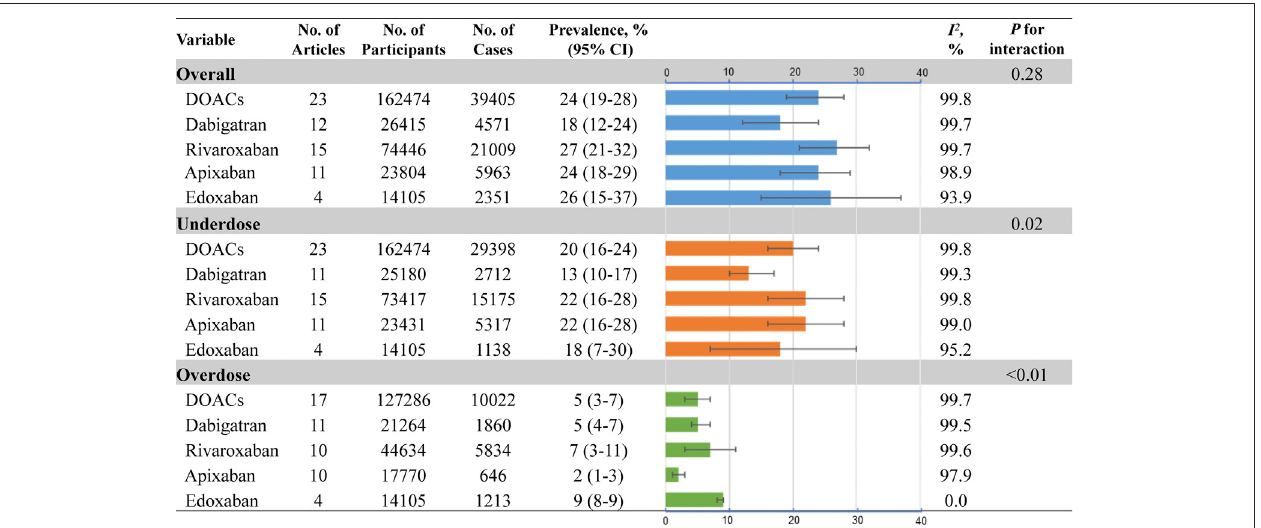
FIGURE 2 | Pooled prevalence of DOAC off-label doses No.: number of included studies; DOACs: direct oral anticoagulants.